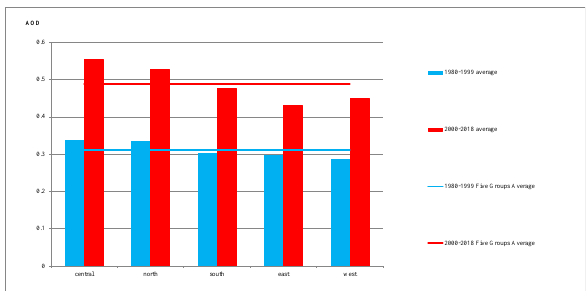
Figure 8. The comparison among the five groups of GDHM between the average AOD in 1980-1999 and the average AOD in